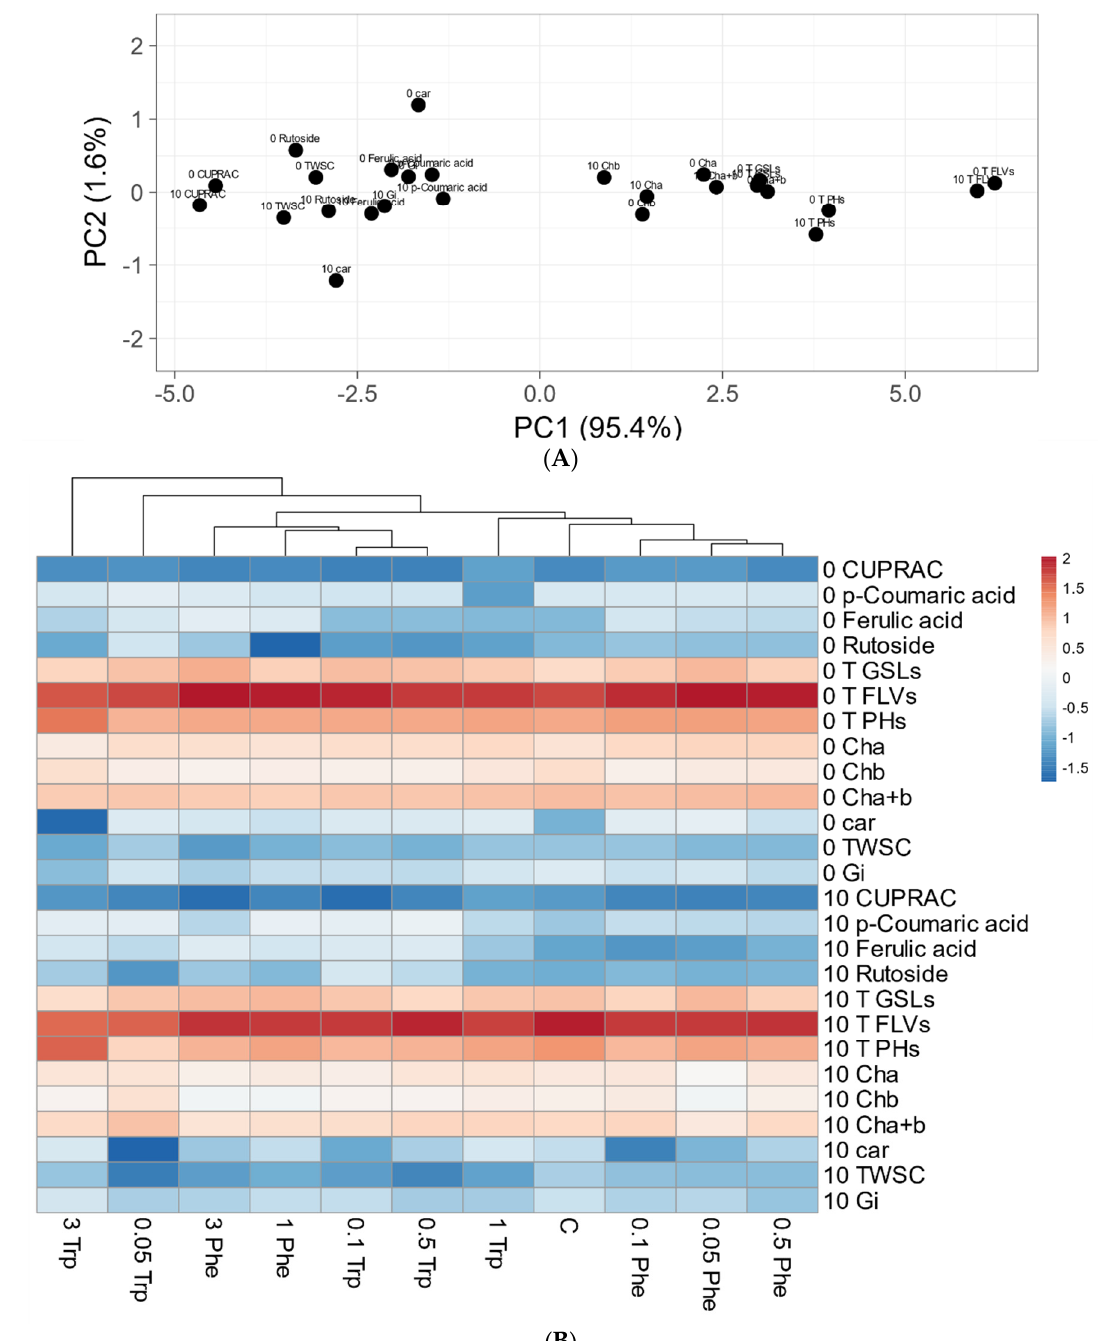
Figure 2. Principal component analysis (PCA) plot of measured bio-chemical parameters for plant material (panel A ) and heat map of biochemical parameters of different treatments (panel B ). Original values are ln(x)-transformed. Unit variance scaling is applied to rows; singular value decomposition (SVD) with imputation is used to calculate principal components. X and Y axis show principal component 1 (PC1) and principal component 2 (PC2) that explain 95.4 and 1.6% of the total variance, respectively. In heat map columns are centered; unit variance scaling is applied to columns. Columns are clustered using correlation distance and average linkage [36].